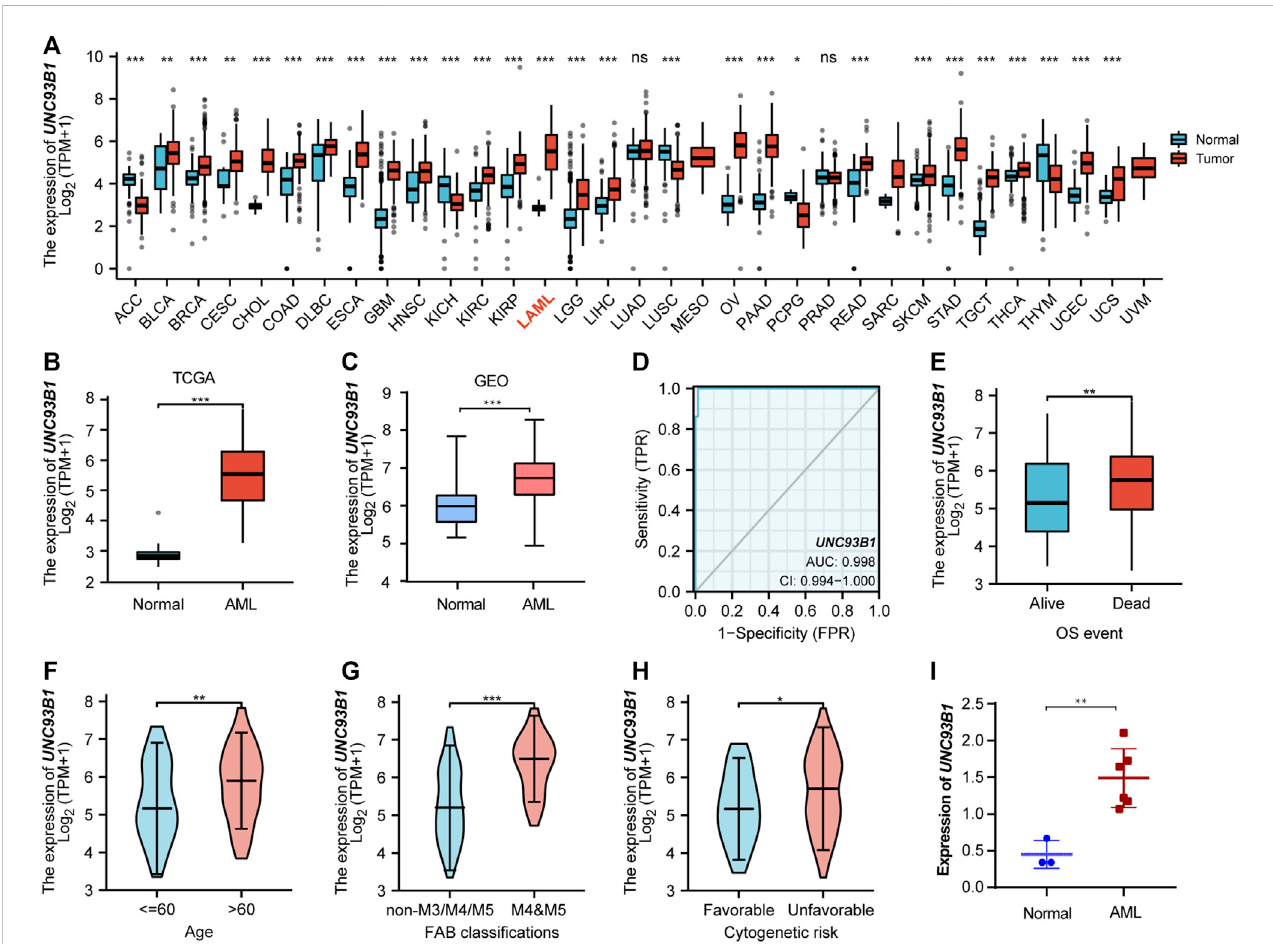
FIGURE 1 High UNC93B1 expression was linked to inferior clinical features in AML. (A) Level of UNC93B1 expression in different tumors from TCGA and GTEx database. (B) Expression levels of UNC93B1 in AML (n = 173) and normal samples ( n = 70). (C) Differential expression of UNC93B1 expression between AML patients from GSE13159 ( n = 252) and normal control from GSE42519 ( n = 44). (D) Receiver operating characteristic analysis (ROC) of UNC93B1 in AML. (E) Expression levels of UNC93B1 in different fi nal OS events. (F) Association of UNC93B1 expression and age. (G) High expression of UNC93B1 in M4/ M5 leukemia according to French-American-British (FAB) classi fi cation. (H) High level of UNC93B1 relative to GAPDH in AML patients ( n = 6) compared to healthydonors( n =3)usingqPCR. (I) Associationofhigh UNC93B1 expressionandunfavorableCytogeneticsaccordingto2017EuropeanLeukemiaNet(ELN) genetic risk strati fi cation guidelines of AML. Wilcoxon rank sum test was used between two groups of unpaired samples and Kruskal – Wallisrank sum test was analyzed among multiple groups of samples. ns: p ≥ 0.05, * p < 0.05, ** p < 0.01, *** p <